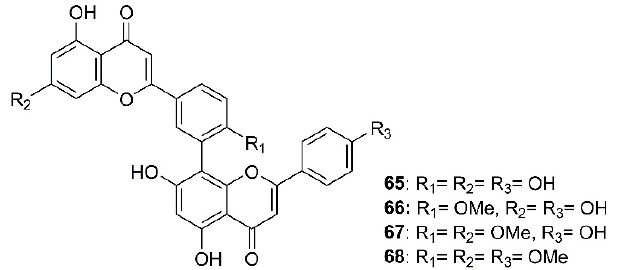
Figure 10. Structure of biflavones 65 – 68 .